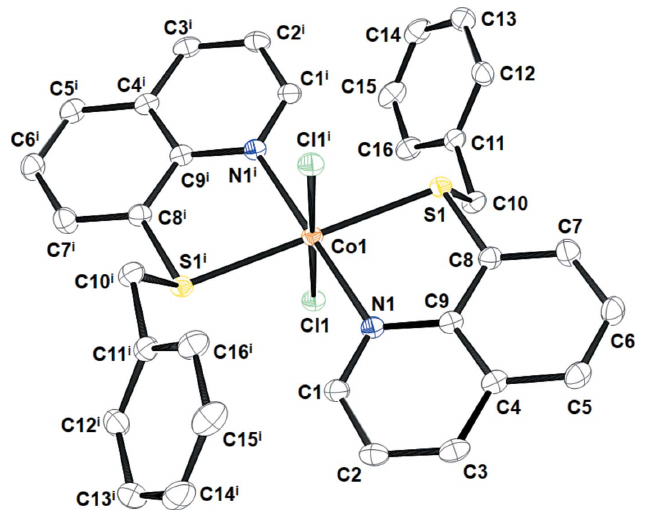
Figure 1 The molecular structure of 2 with atom numbering. Dispacement ellipsoids are drawn at the 50% probability level. H atoms are omitted for clarity. [Symmetry code: (i) 1 (cid:5) x , 1 (cid:5) y , 1 (cid:5) z